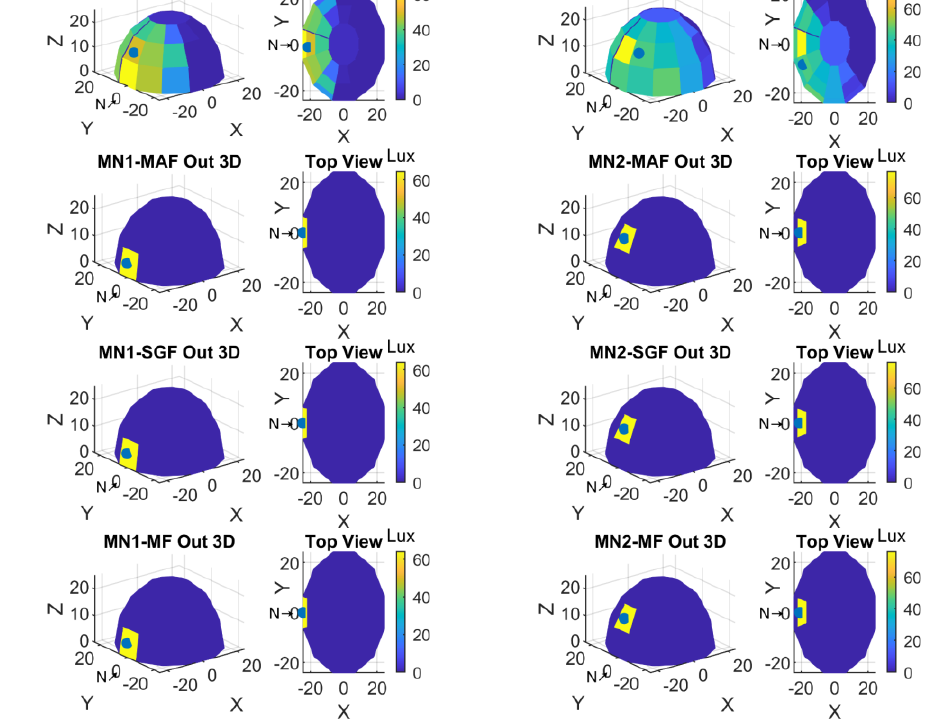
Figure 12. Spherical and top view of MN1 and MN2 experiment result. Graphic plots for the measurements from MN3 and MN4 were shown in Figure 13.